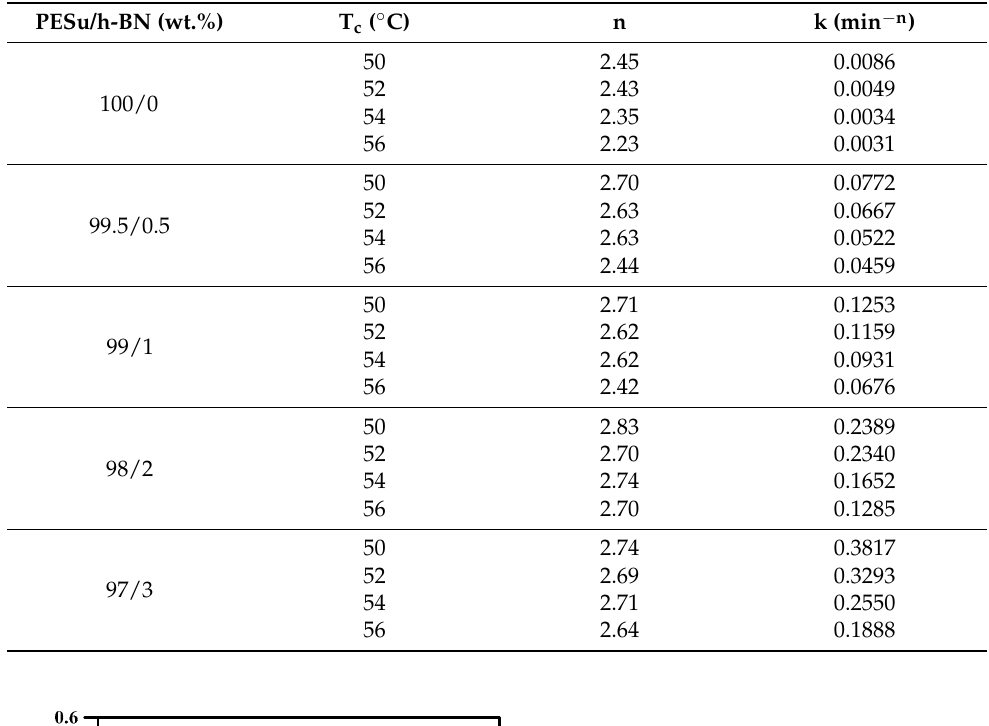
Table 1. The Avrami kinetic parameters for the isothermal crystallization behaviors of PESu/h- BN composites.